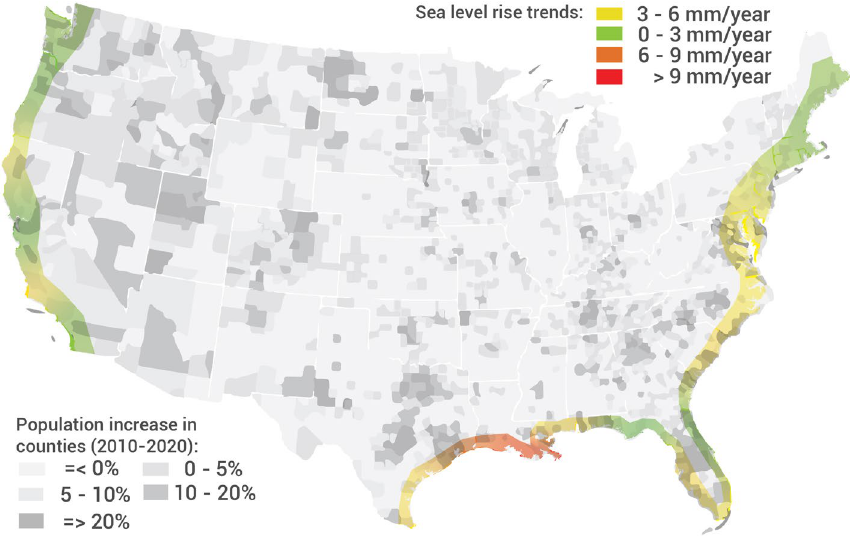
Figure 1. Relative sea-level trends at coastal counties in the US 23 overlapping with the population growth in the last 10 years 24,25 . The software used to develop the map in this figure is QGIS 3.16 (https:// qgis.